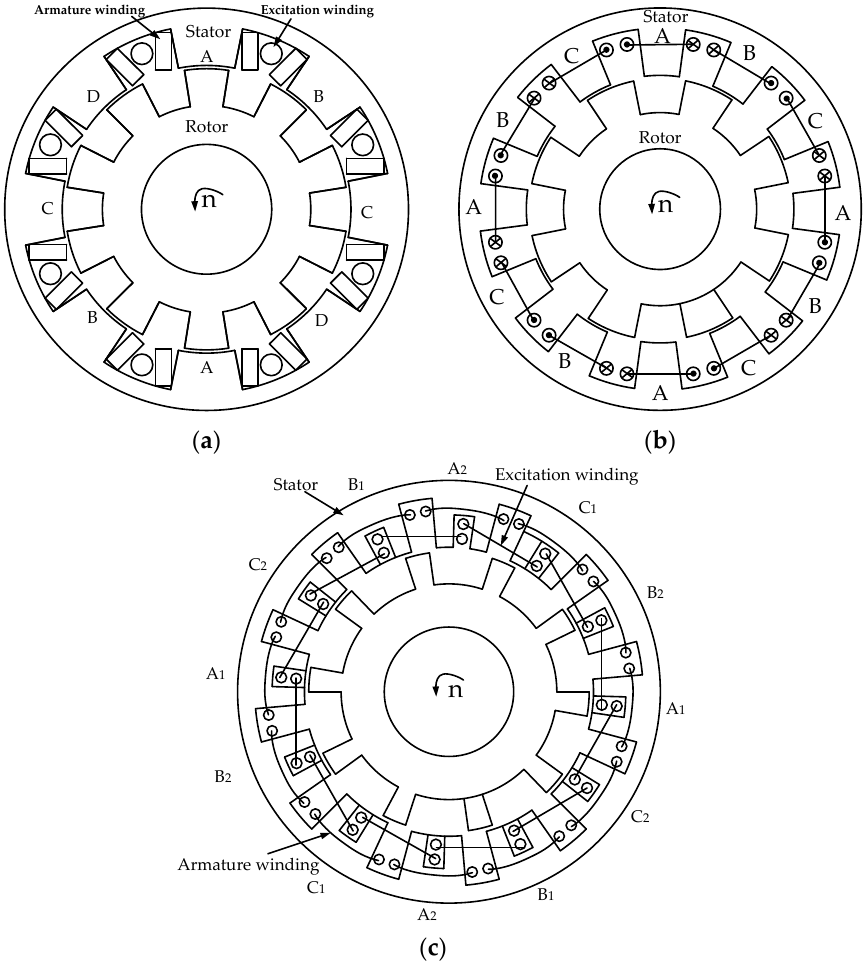
Figure 1. Stator excited VRM. ( a ) WFDSM [3]. ( b ) SRM [4]. ( c ) EEFSM